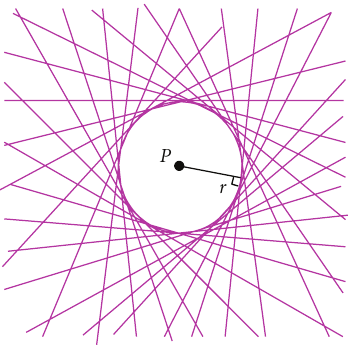
Figure 3: Illumination the production of the ring caused by the horizontal o ff